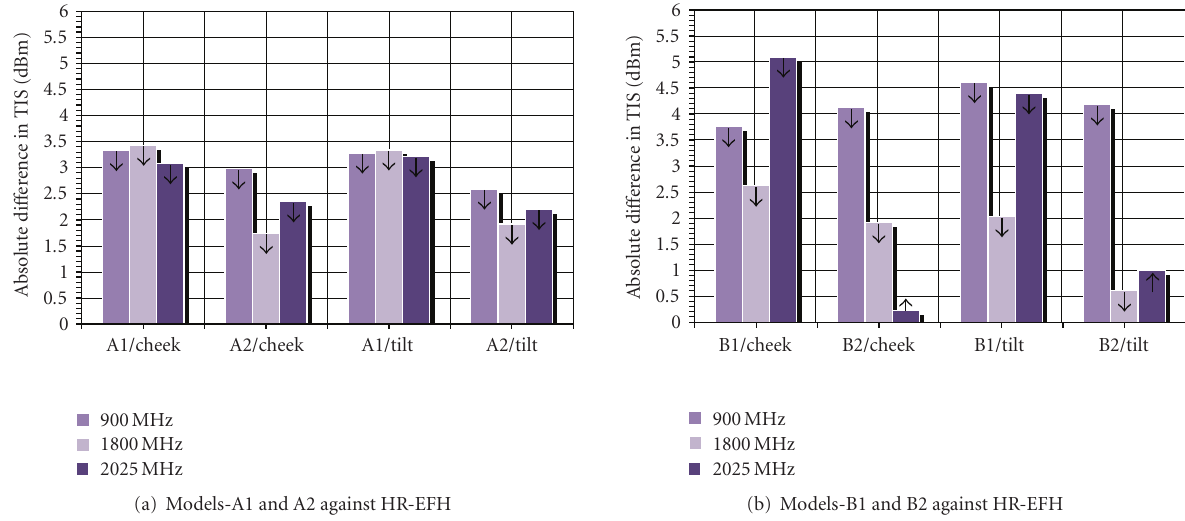
Figure 12: Absolute di ff erence in the TIS levels owing to hand-hold alteration at di ff erent antenna/handset positions against HR-EFH in GSM900, GSM1800, and